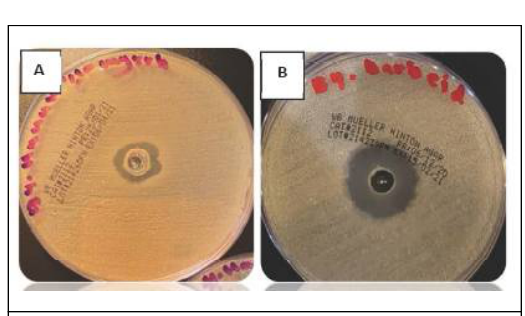
Figure 5: The antibacterial activity of (A) C. myrrh extract and (B) barbicide solution against Macrococcus spp